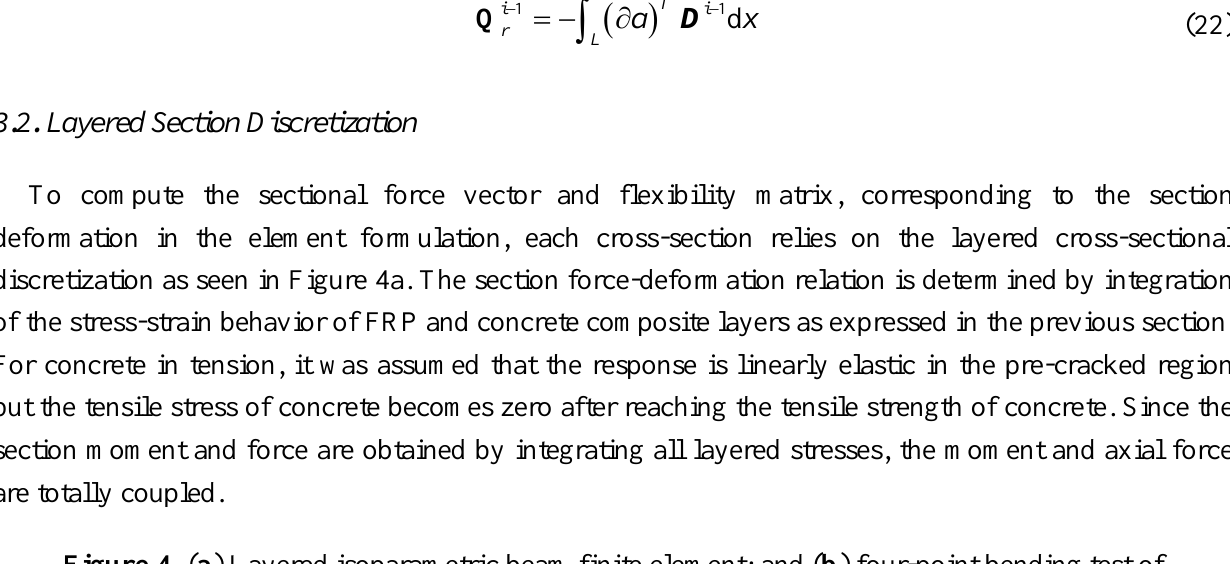
Figure 4. ( a ) Layered isoparametric beam finite element; and ( b ) four-point bending test of FRP and concrete circular